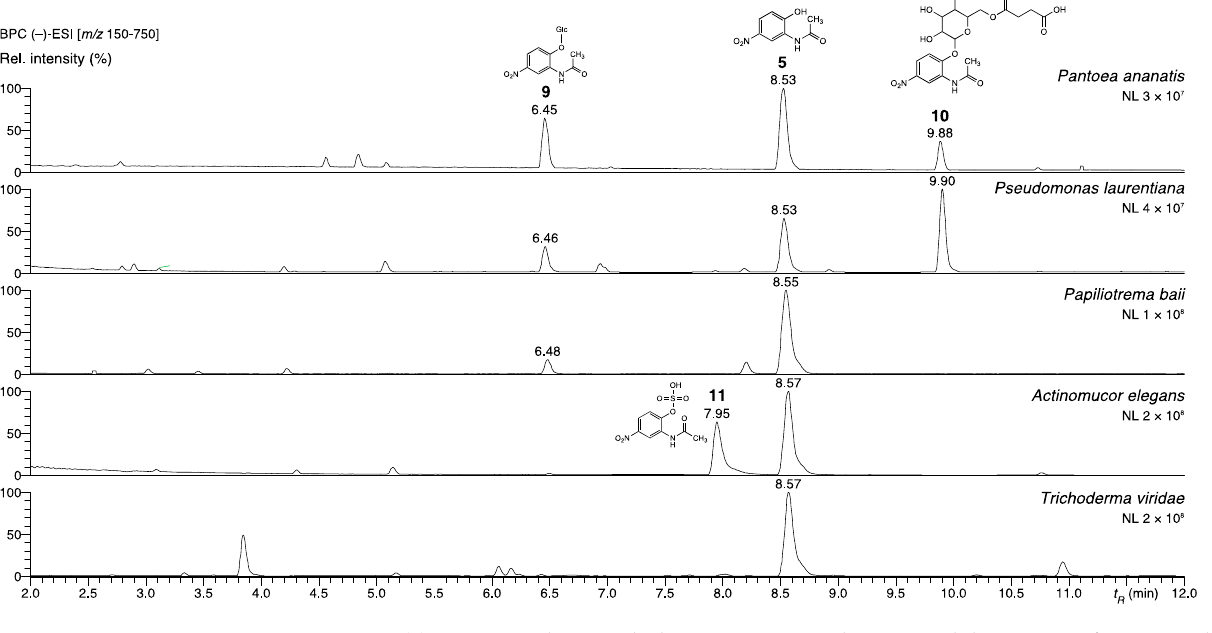
Figure 5. LC-(–)-ESI-HRMS base peak chromatograms with annotated derivatives of compound 5 in total bacterial or fungal culture extracts after incubation with 5 . Analytical data can be consulted in Supplementary Materials (Figure S8, Table S4).